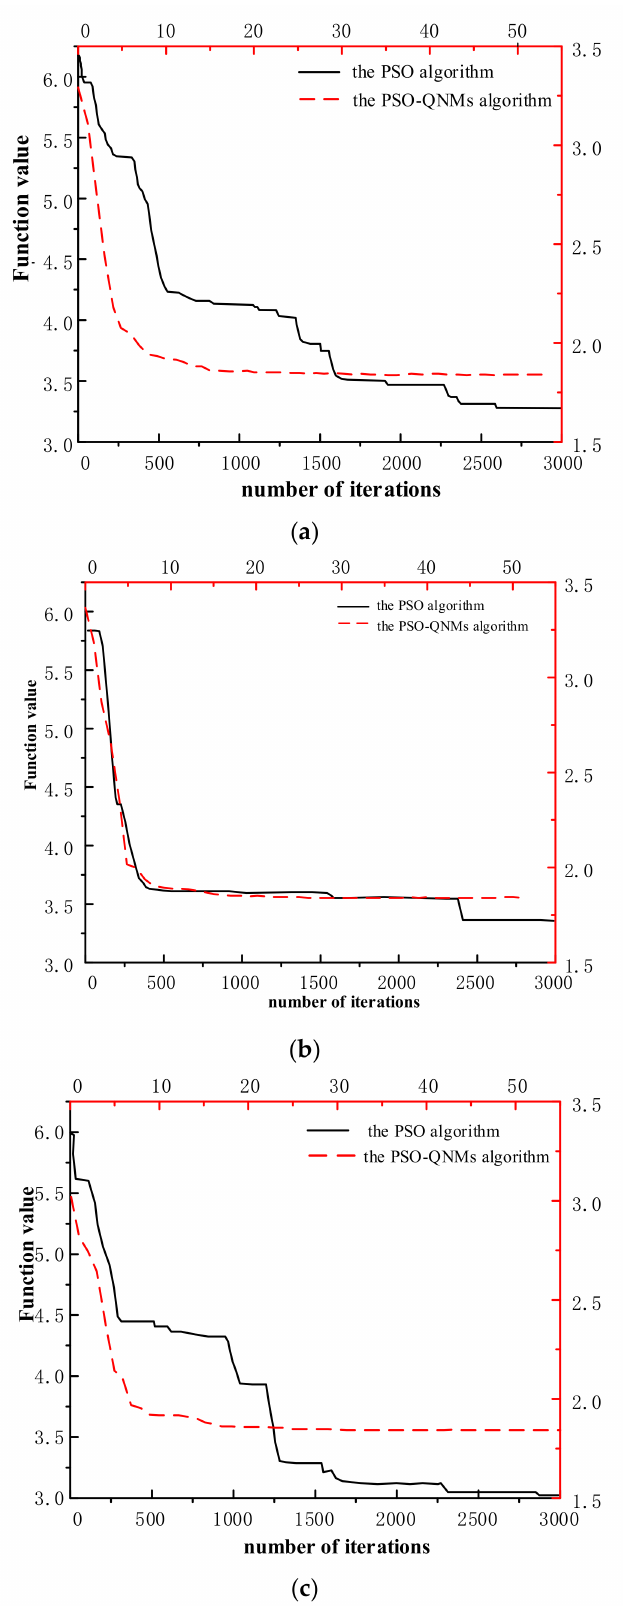
Figure 4. Intelligent optimization method iteration curve: ( a ) group 1, ( b ) group 2, ( c ) group